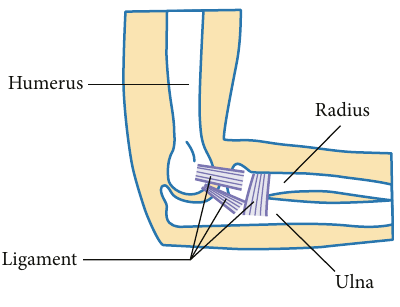
Figure 1: Schematic diagram of the human elbow